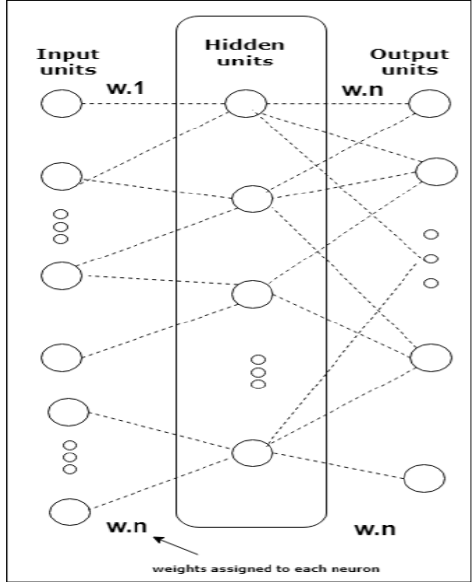
Figure 1. General architecture of ANN [8]